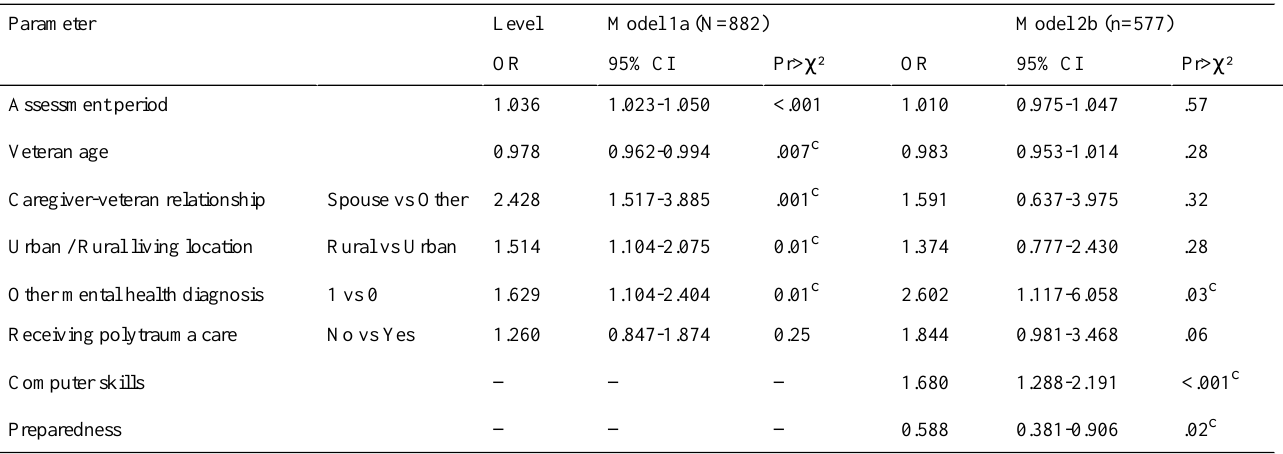
Table 6. Logistic regression model predicting at least one use of a clinical mHealth